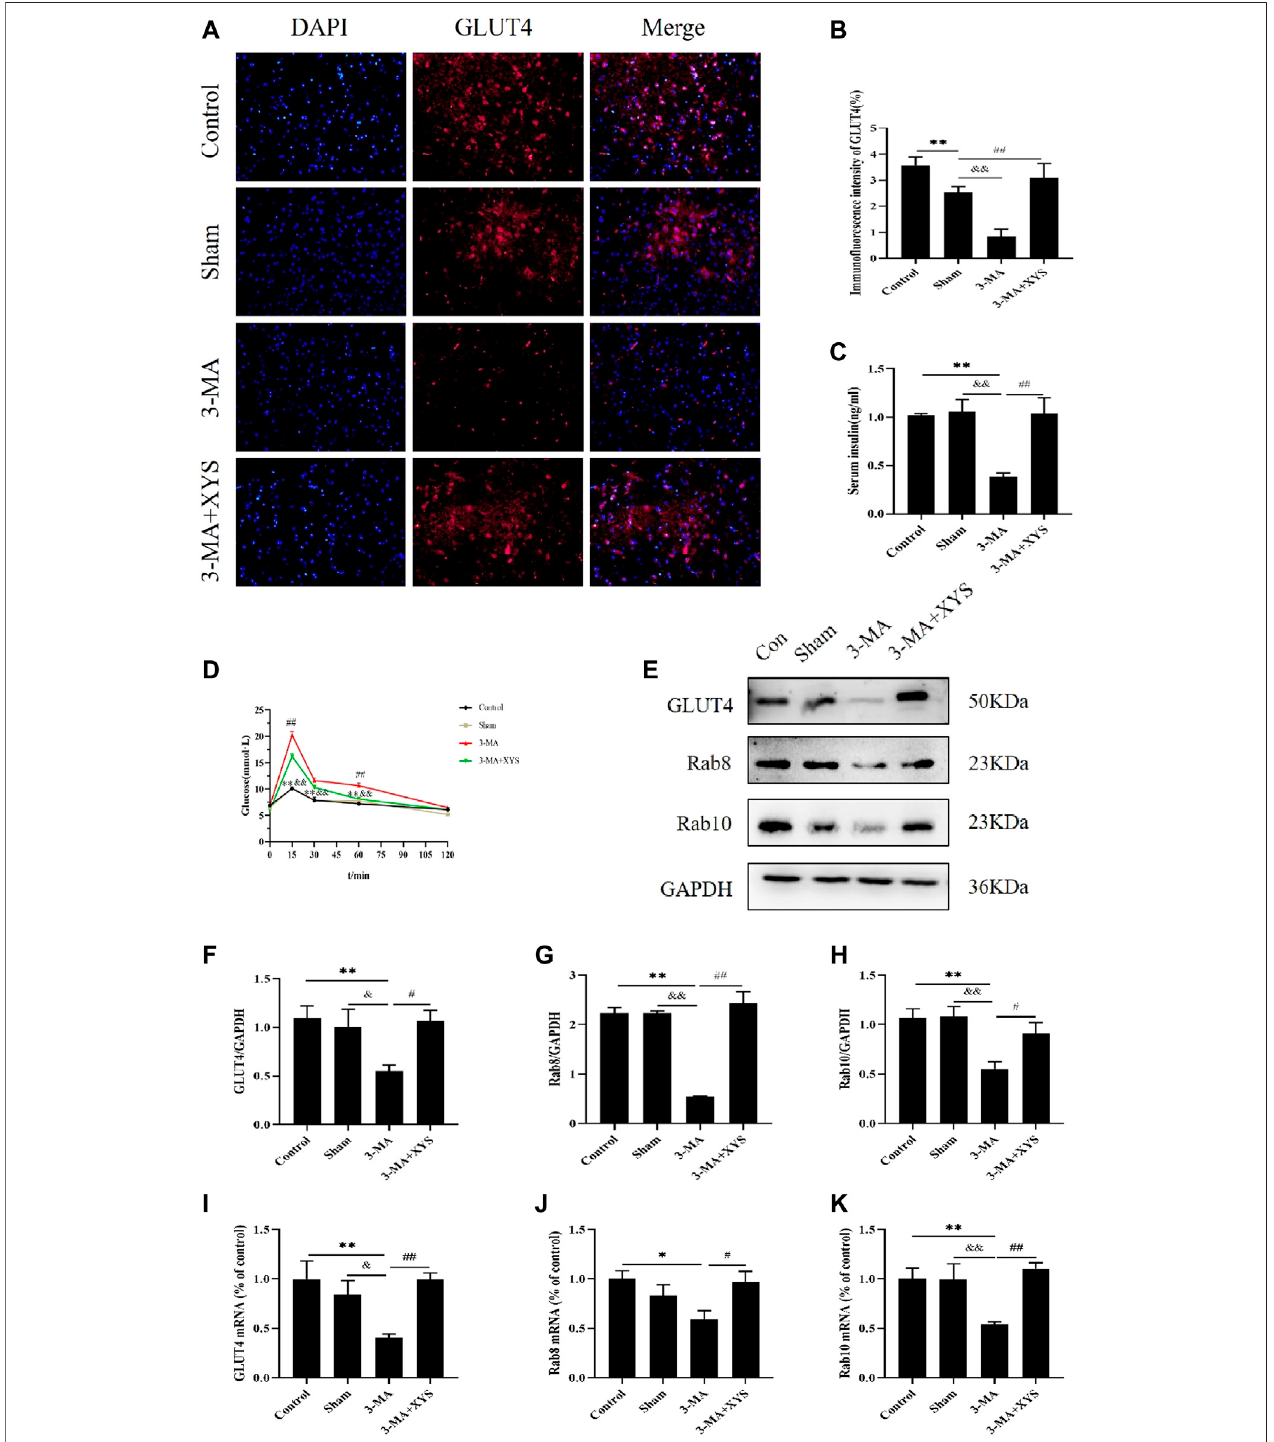
FIGURE 9 | Effect of Xiaoyaosan on glucose metabolism in hypothalamus of mice injected with 3-MA. (A) Immuno fl uorescence expression of GLUT4 in hypothalamusofthemice(scalebar=20 µm). (B) Immuno fl uorescenceintensityofGLUT4(%)(F(3,8)=10.900, p =0.0034,n=3). (C) Seruminsulinlevelofthemice(F (3, 16) = 9.543, p = 0.0008, n = 5). (D) The blood glucose of the mice (F (3, 56) = 22.165, p < 0.0001, n = 15). (E) Representative western blotting of GLUT4, Rab8 and Rab10expressions. (F) QuantitativeanalysisofproteinlevelsofGLUT4(F(3,16)=4.001, p =0.0266,n=5). (G) QuantitativeanalysisofproteinlevelsofRab8(F(3, 16) =23.664, p < 0.0001,n=5). (H) Quantitative analysisofproteinlevels ofRab10 (F(3, 16)=6.453, p =0.0045,n=5). (I) Theexpression ofGLUT4mRNA (F(3, 12)= 5.221, p =0.0155,n=4). (J) TheexpressionofRab8mRNA(F(3,12)=3.655, p =0.0443,n=4). (K) TheexpressionofRab10mRNA(F(3,12)=6.112, p =0.0091,n= 4). The values represent the mean ± SEM. p p < 0.05 or pp p < 0.01 compared with the control group. & p < 0.05, & p < 0.01 compared with the 3-MA group. # p < 0.05, ## p < 0.01 compared with the 3-MA group.